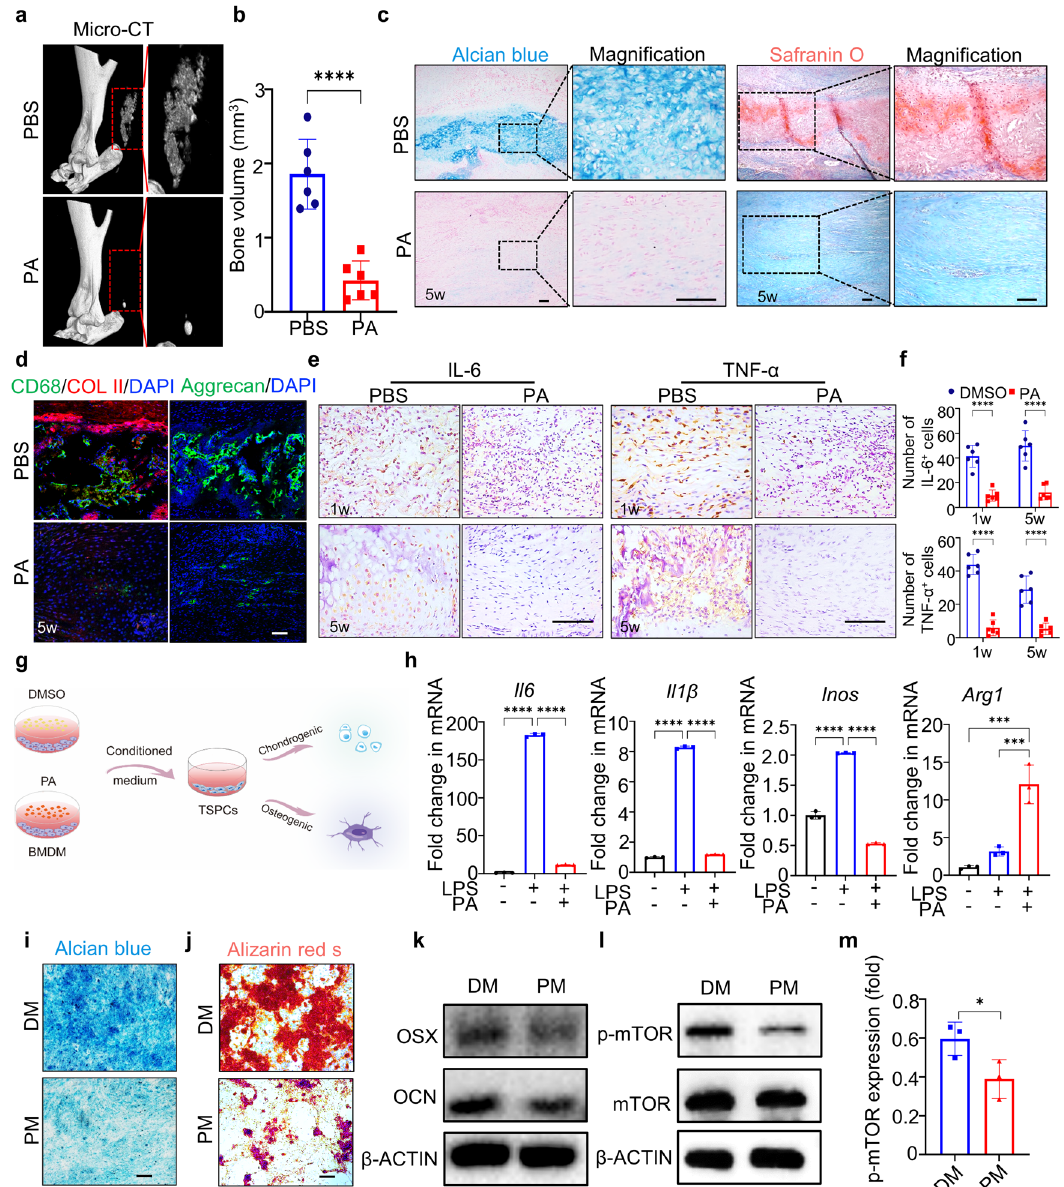
Fig. 3 PA prevents tendon heterotopic ossi fi cation through inhibiting aberrant differentiation of TSPCs by attenuating pro-in fl ammatory cytokine secretion in macrophages. a Micro-CT images of repaired tendons from PBS and PA groups at 5 weeks. b Semi-quanti fi cation of ( a ). Data are presented as mean ± SD. **** p < 0.0001, n = 6. c Alcian blue staining and Safranin O staining images of repaired tendons from PBS and PA groups at 5 weeks. Scale bar, 100 μ m. d Immuno fl uorescence staining of chondrocyte markers COL II and Aggrecan in neo-tendons from PBS and PA groups at 5 weeks. Scale bar, 100 μ m. e Immunohistochemical staining of IL-6 and TNF- α in neotendons from PBS and PA groups at 1 and 5 weeks. Scale bar, 100 μ m. f Semi-quanti fi cation of e . Data are presented as mean ± SD. **** p < 0.0001, n = 6. g Schematic illustration of the process for inducing TSPCs chondrogenic and osteogenic differentiation. h RT-PCR of Il6 , Il1 β , Inos , and Arg1 expression in DMSO- and PA-treated BMDMs under LPS stimulation. Data are presented as mean ± SD. *** p < 0.001 and **** p < 0.0001, n = 3. i Alcian blue staining of TSPCs under chondrogenic differentiation for 14 days. Scale bar, 100 μ m. j ARS staining of TSPCs under osteogenic differentiation for 21 days. Scale bar, 100 μ m. k Western blotting of OSX and OCN in TSPCs. l Western blotting of p-mTOR in TSPCs at 7 days. m Semi- quanti fi cation of l . Data are presented as mean ± SD. * p < 0.05, n = 3. DM means conditioned medium from DMSO-treated BMDMs under LPS stimulation; PM means conditioned medium from PA-treated BMDMs under LPS